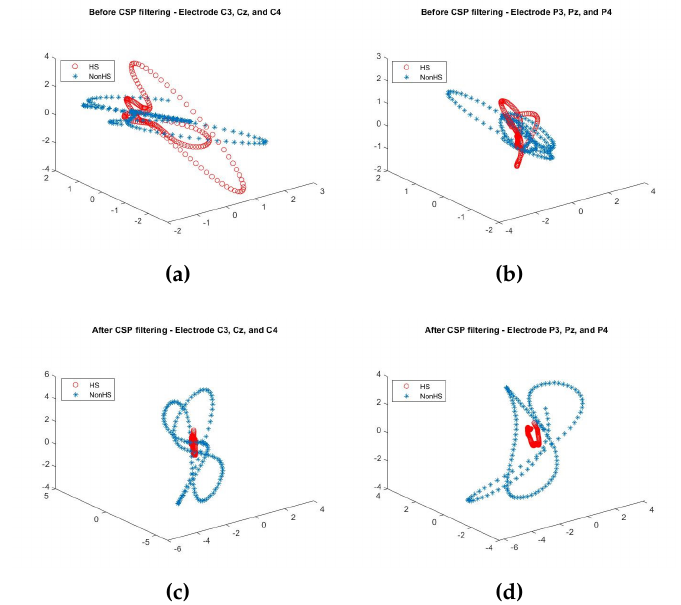
Figure 7. The 3D-scatter plots of 300 samples of EEG for HS vs. Non-HS events from (C3, Cz, C4) electrodes and (P3, Pz, P4) electrodes; where ( a , b ) are the plots before CSP filtering, and ( c , d ) are the plots after CSP filtering.